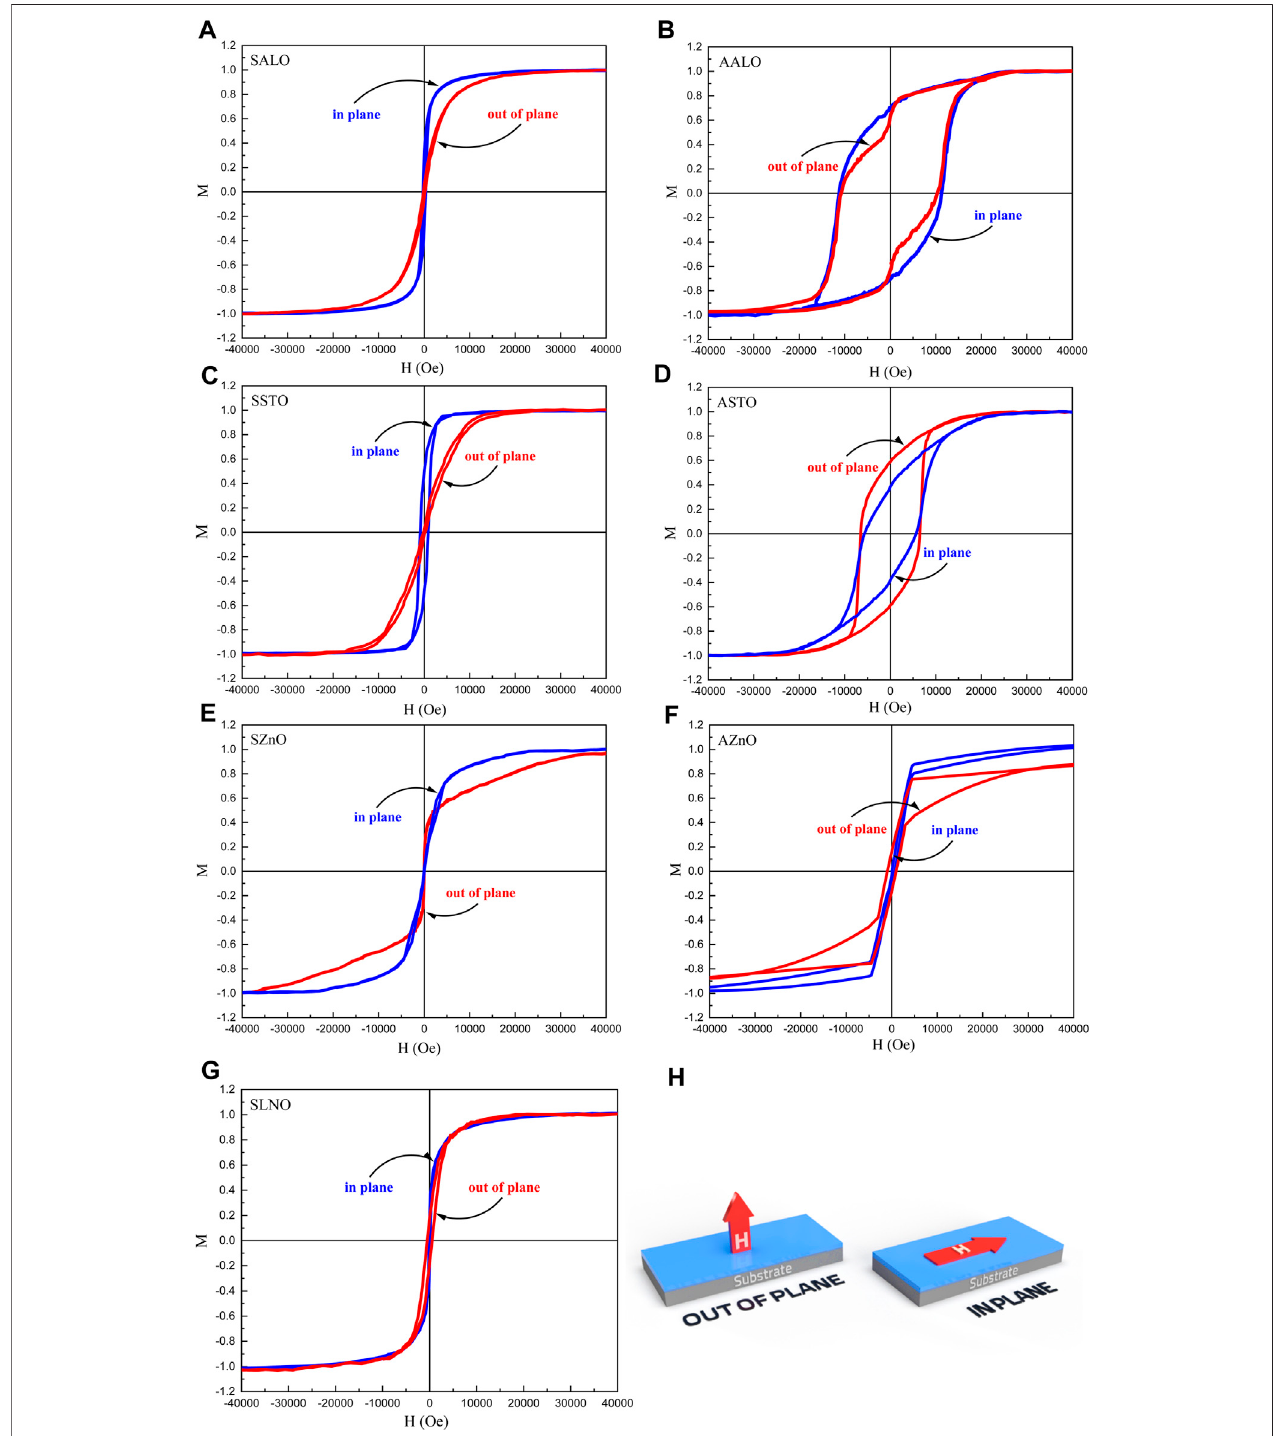
FIGURE 5 | Normalized magnetic hysteresis loops of fi lms with various substrates, before annealing: (A) SALO, (C) SSTO, (E) SZnO, and (G) SLNO, and after annealing: (B) AALO, (D) ASTO, and (F) AZnO. (H) Schematic of the applied magnetic fi eld direction during the M – H measurements of the SrM fi lm. Figure 3B that the peak (695 cm − 1 ) associated with the trigonal annealing. In contrast, the Raman spectra shown in Figure 3C site of the SrM is relatively sharp, which shows that strontium illustrate a red shift because the lattice parameter of ZnO is larger ferrite fi lms have an improved crystalline structure after than SrM, and therefore, a tensile strain exists in these fi lms,